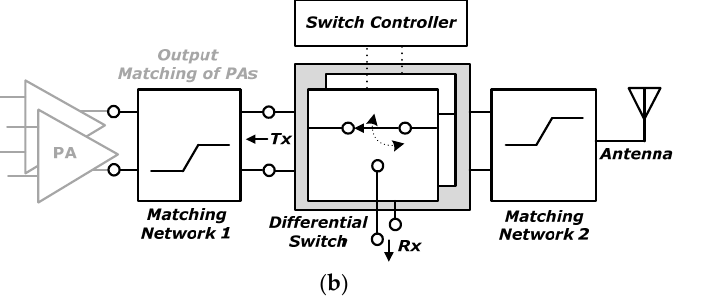
Figure 1. Block diagram of transmitter front-end. ( a ) Conventional structure with a single-ended switch. ( b ) Proposed structure with a differential switch employing impedance transformation technique.